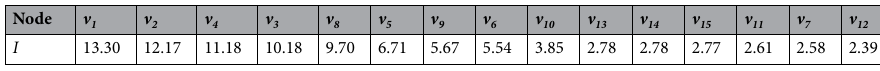
Table 5. Influence of the nodes in the sample network presented in Fig. 1.